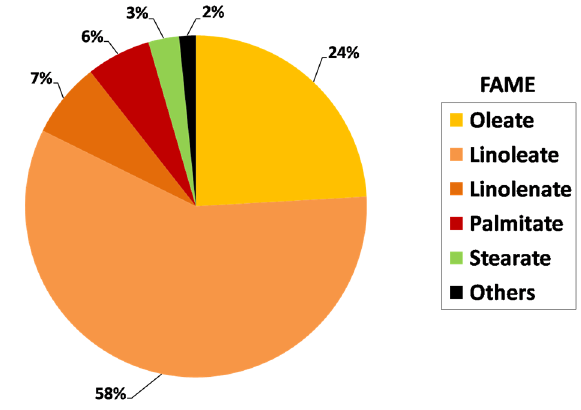
Figure 5. Fatty acid methyl ester of cardoon biodiesel.